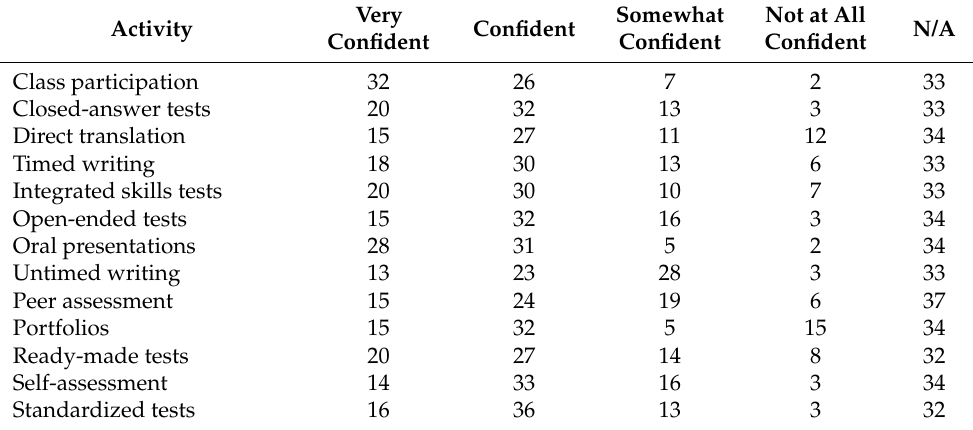
Table 6. Confidence using assessment activity by